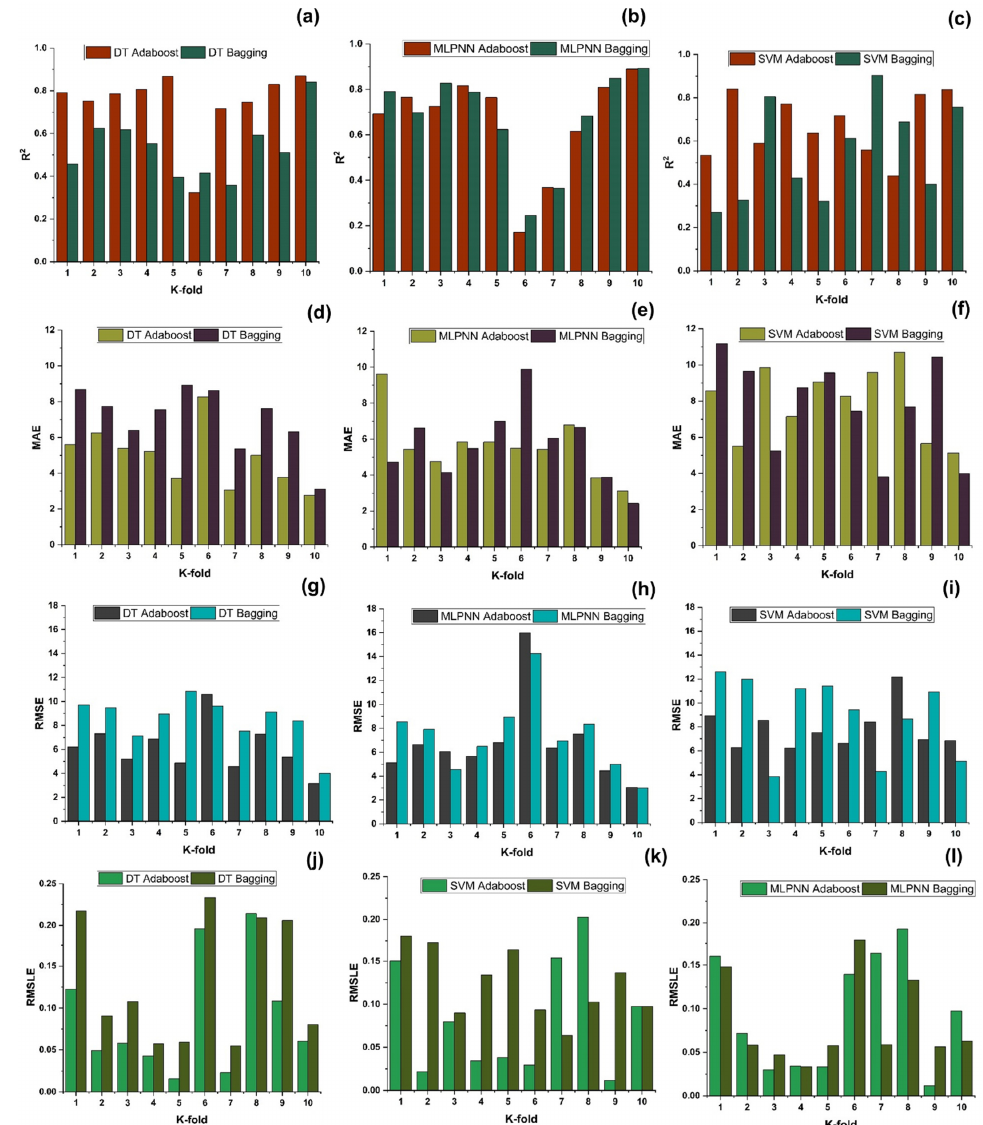
Figure 23. Compressive strength models ( a – c ) indicates R 2 models’ result validated with K fold; ( d – f ) indicates MAE models’ result validated with K fold; ( g – i ) indicates RMSE models’ result validated with K fold; ( j – l ) indicates RMSE models’ result validated with K fold.